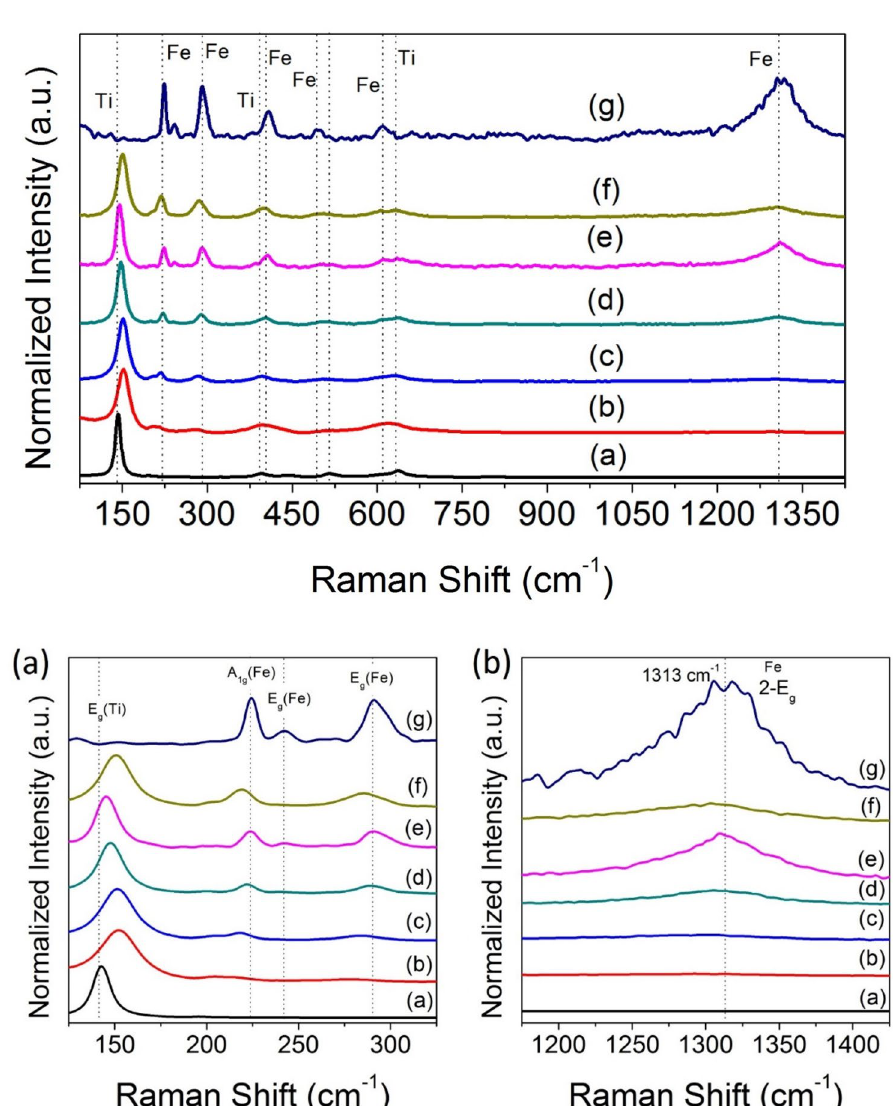
Figure 7. Raman spectrum of ( a ) n-TiO 2 , ( b ) 9% wt n-TiO 2 @α-Fe 2 O 3 , ( c ) 4% wt n-TiO 2 @α-Fe 2 O 3 , ( d ) 2.3% wt